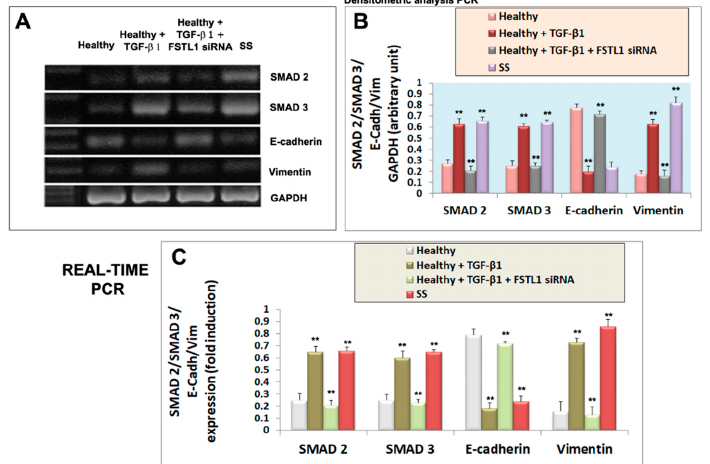
Figure 4. Effect of FSTL1 gene silencing on E-cadherin, vimentin, SMAD2 and SMAD3 gene expres- sion evaluated by RT-PCR ( A , B ) and quantitative Real-Time PRC ( C ). ( A ): E-cadherin, vimentin, SMAD2, and SMAD3 gene expression were determined by RT-PCR in healthy SGEC (control, lane 1) cultured for 24 h with 10 ng/mL of TGF- β 1 in which FSTL1 gene silencing was induced (lanes 2, 3). SS SGEC mRNA was used as a positive control (lane 4). ( B ) represent the densitometric analysis. Real-time PCR conducted on SGEC submitted to some treatments was shown in ( C ). GAPDH ( A , B ) and β -2-microglobulin ( C ) were used as reference genes for mRNA analyses. Values represent the mean ± SE of three independent experiments, with ** = p < 0.01.